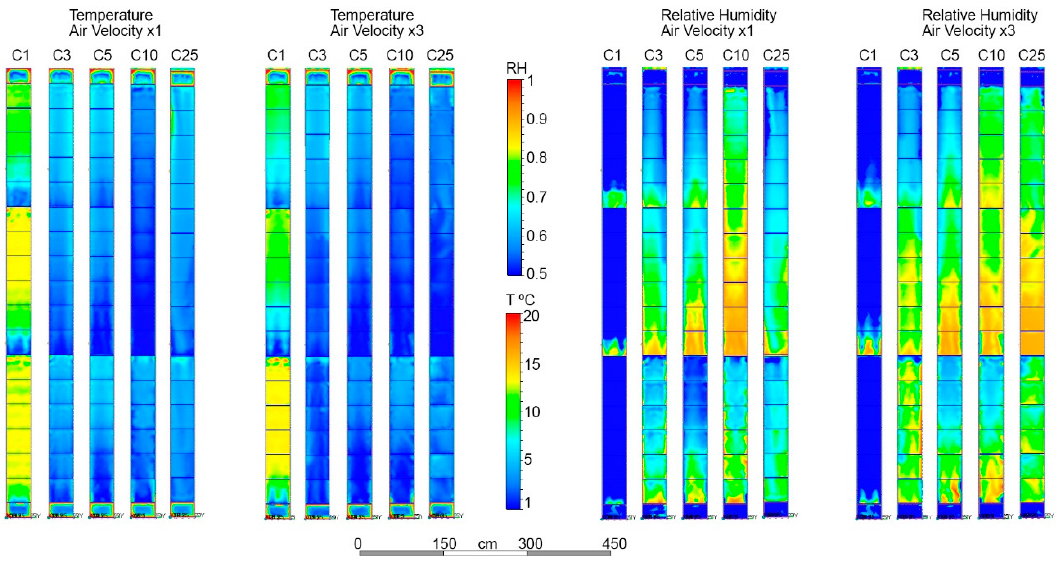
Figure 5. Temperature and humidity for each of the ten cases studied.